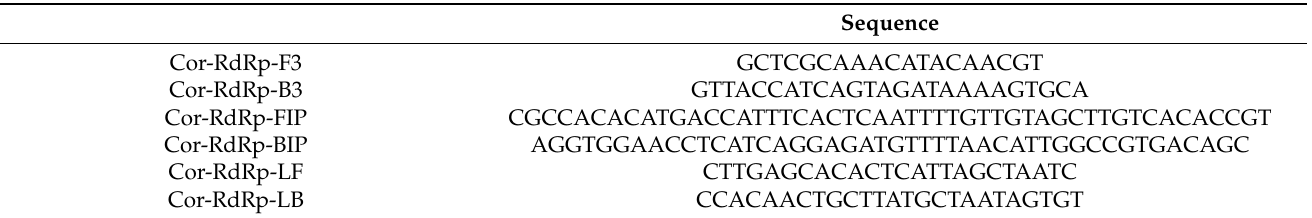
Table 1. Sequences of templates and